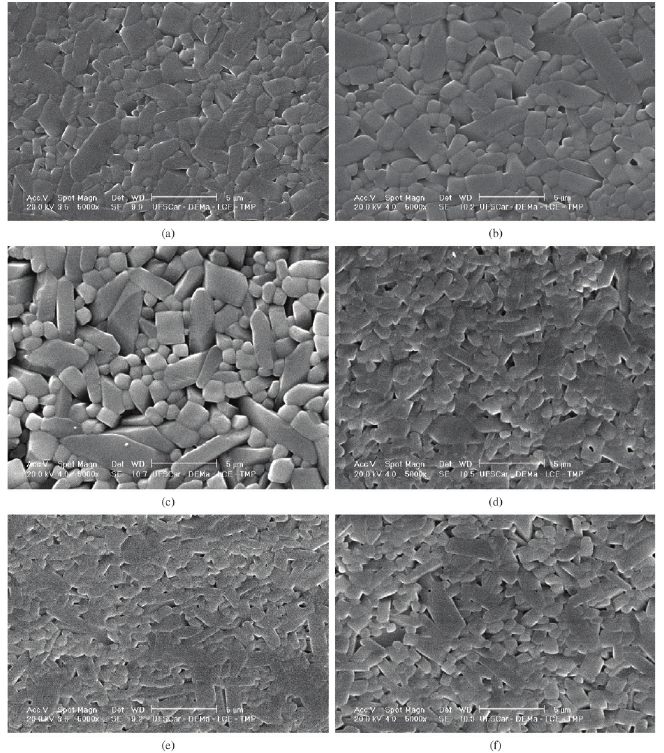
Figure 11. SEM micrographs of samples fast sintered at a heating rate of 80 o C/min: (a) 0.5M, (b) 1M, (c) 2M, (d) 0.5L, (e) 1L, and (f)